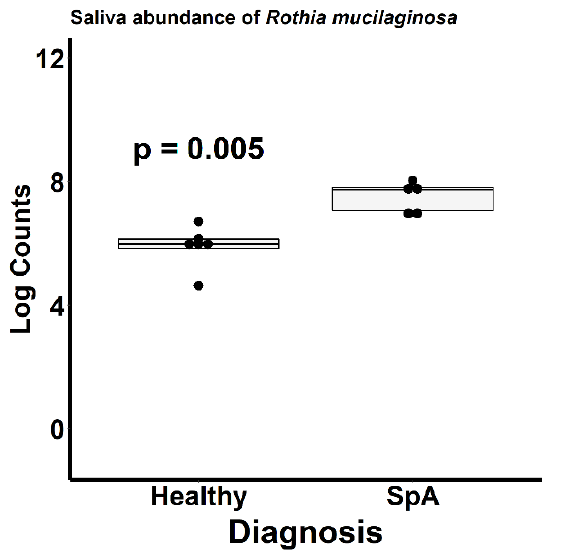
Figure 7. Relative abundance of Rothia mucilaginosa within the saliva of patients with Spondyloarthritis (SpA) and healthy controls.